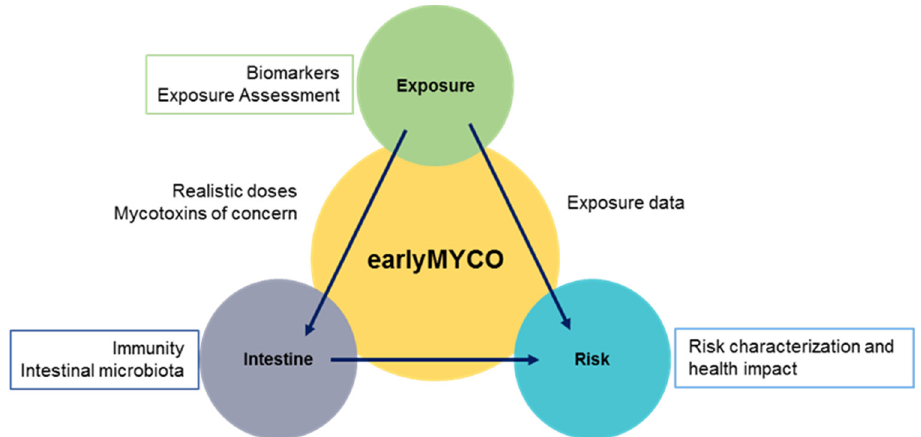
Figure 1. Conceptual framework of earlyMYCO project.